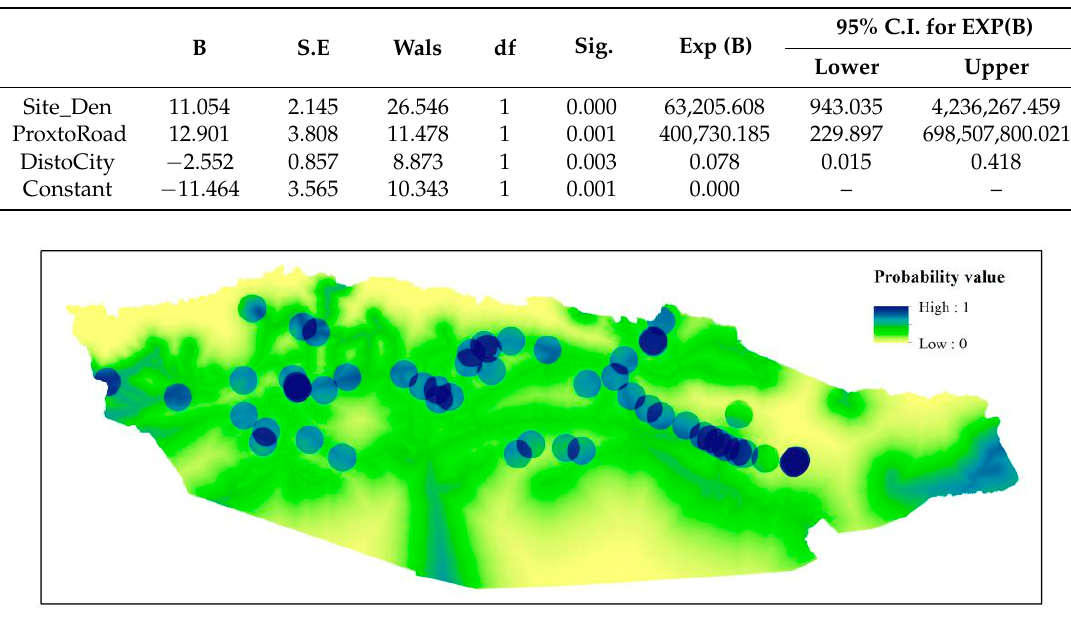
Figure 6. Logistic regression of defensive related sites in the Han Dynasty.